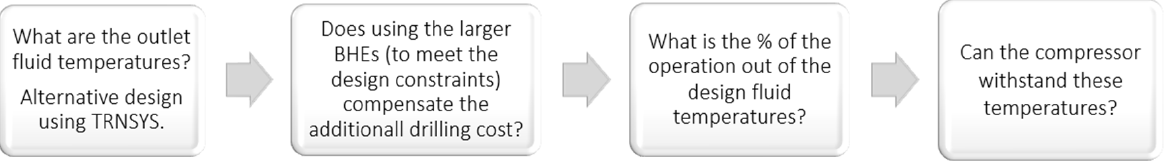
Figure 6. Methodology flux for the techno-economic validation of the preliminary